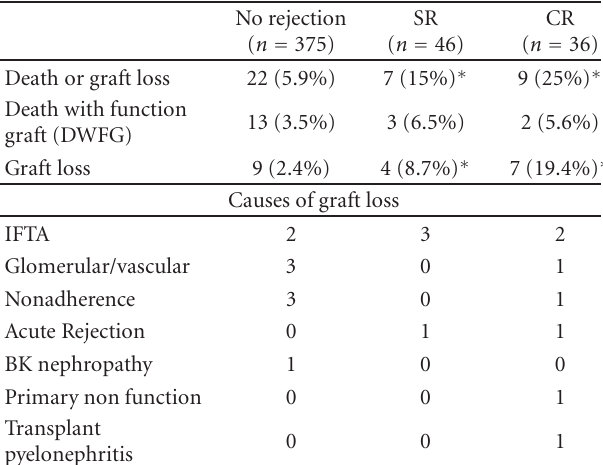
Table 6: Deaths and graft